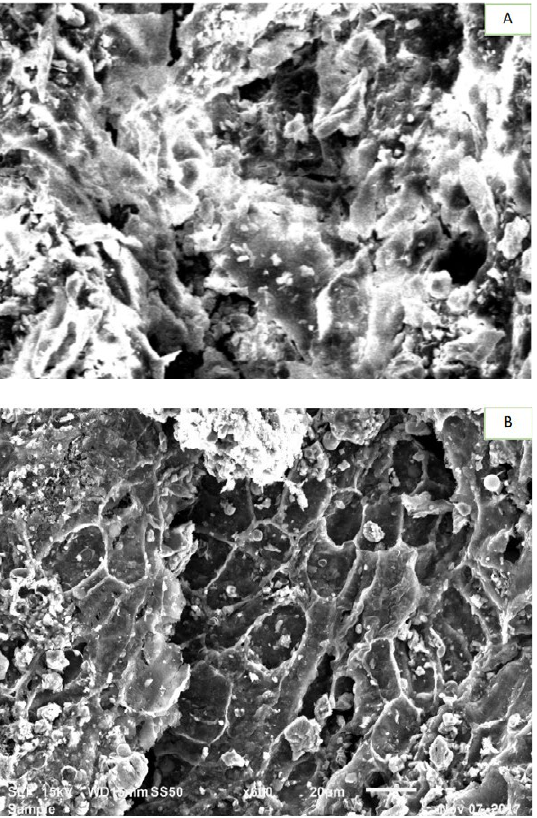
Fig. 1: The SEM of (A) before and (B) after the biochar was produced from OPKS Fig. 2. The FTIR spectra of (a) before, and (b) after, conversion of OPKS into activated carbon